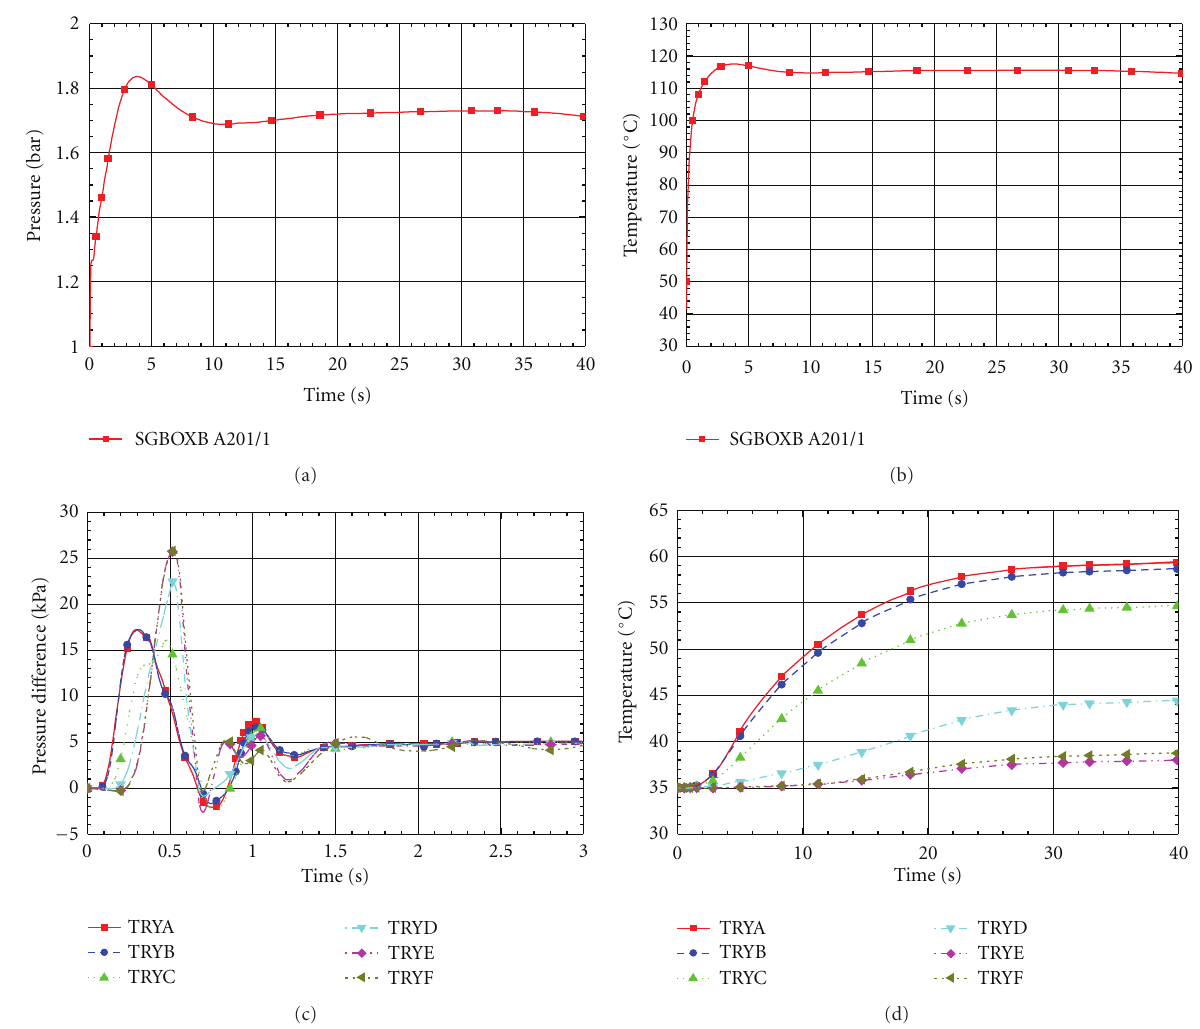
Figure 15: Calculation of LB LOCA at unit 3 of Kola NPP with the COCOSYS code. (a) Pressure history in the break node A201/1; (b) temperature in the break node A201/1; (c) pressure di ff erence across the BC wall; (d) BC water